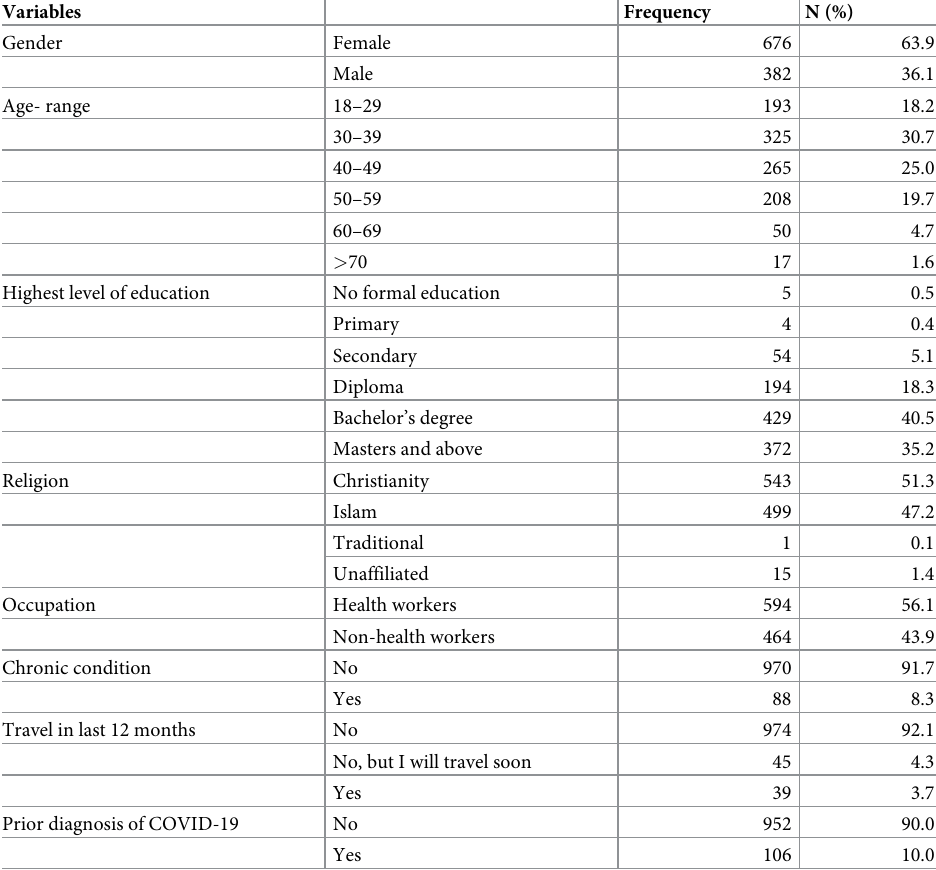
Table 1. Sociodemographic characteristics of respondents (N =